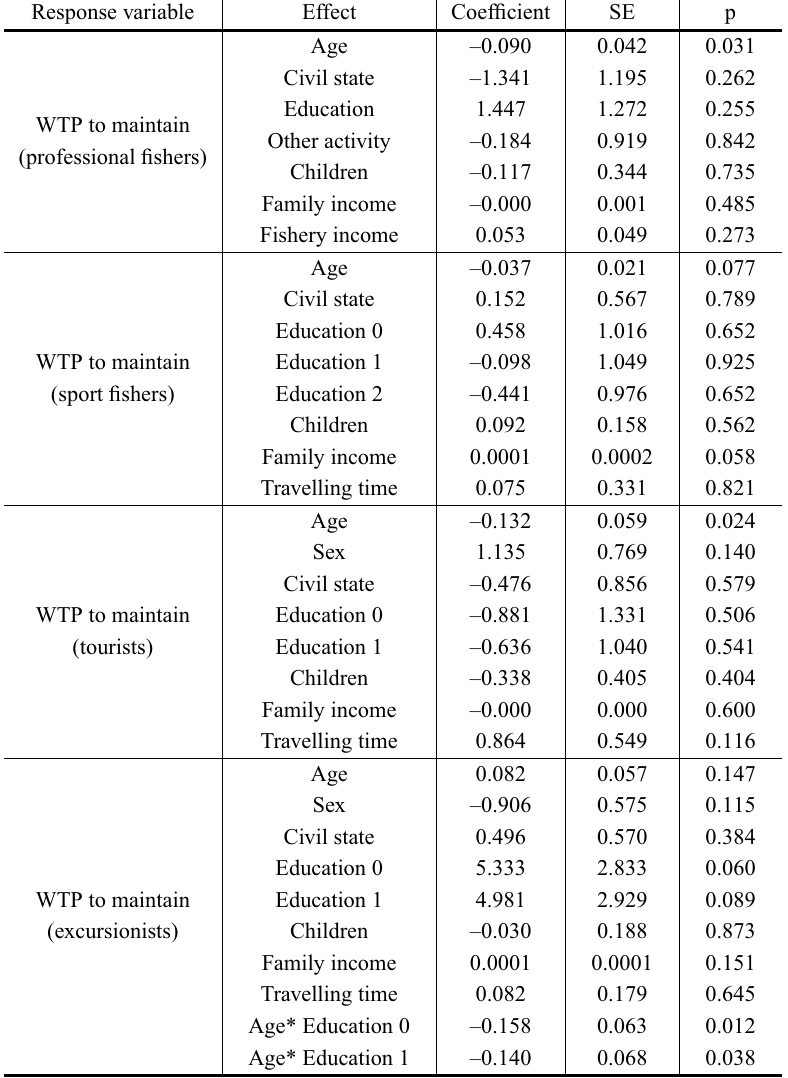
Results from the logistic regression analyses on the Willingness to Pay (WTP) to maintain the environment of the Emas waterfall in its current conditions. Considering the overall model for the professional fishers: Log-likelihood